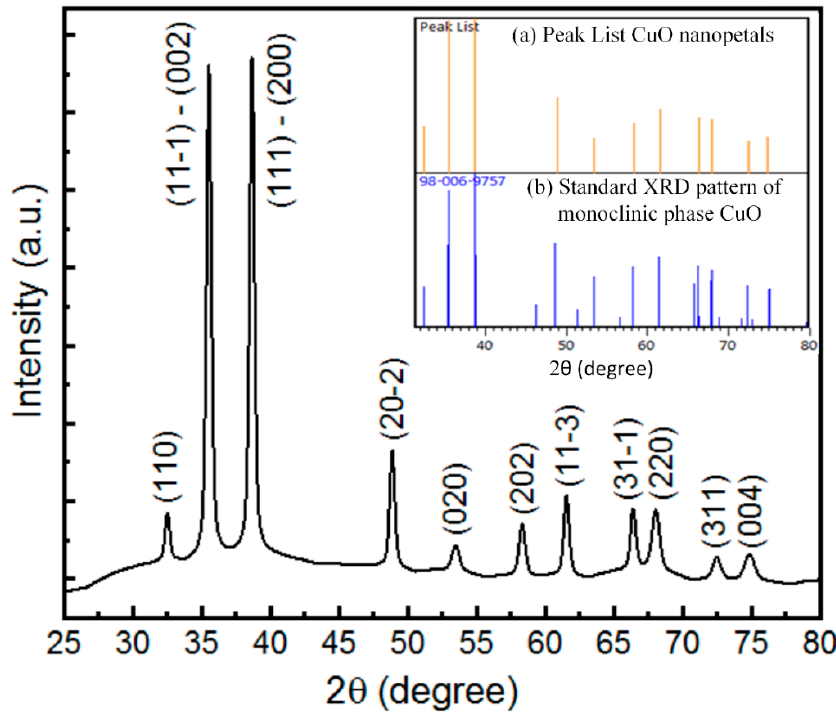
Figure 2. X-Ray di ff raction (XRD) patterns of CuO nanopetals synthesized by simple hydrothermal at Figure 2. X-Ray diffraction (XRD) patterns of CuO nanopetals synthesized by simple hydrothermal 110 ◦ C for 3 at 110 °C for 3 h.